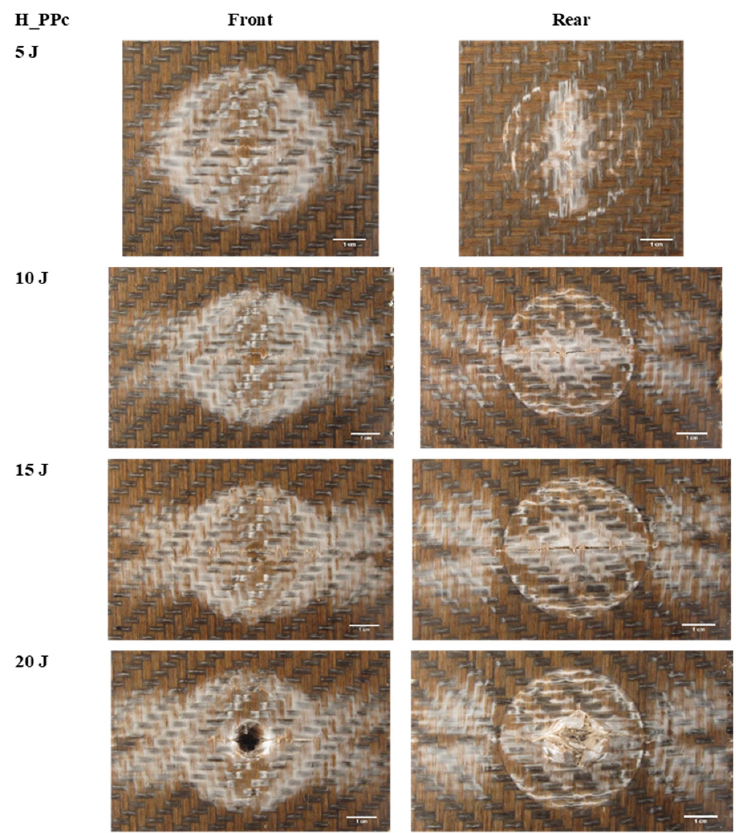
Figure 13. Close-up view of impact damage progression on front and rear surfaces of PPc-based impacted specimens.